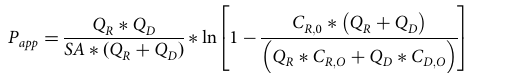
primary antibodies (Supplementary Table 2): rabbit anti-TH (1:500;abcam, ab6211), chicken anti-TH (1:100;abcam, ab76442), goat anti-GFAP (1:300;abcam, ab53554), mouse anti-TH (1:100;Sigma, T2928), Rabbit anti-FOXA2 (1:200;Cell Signaling, 8186), rabbit anti-LMX1A (1:100;Sigma, ZRB1373), mouse